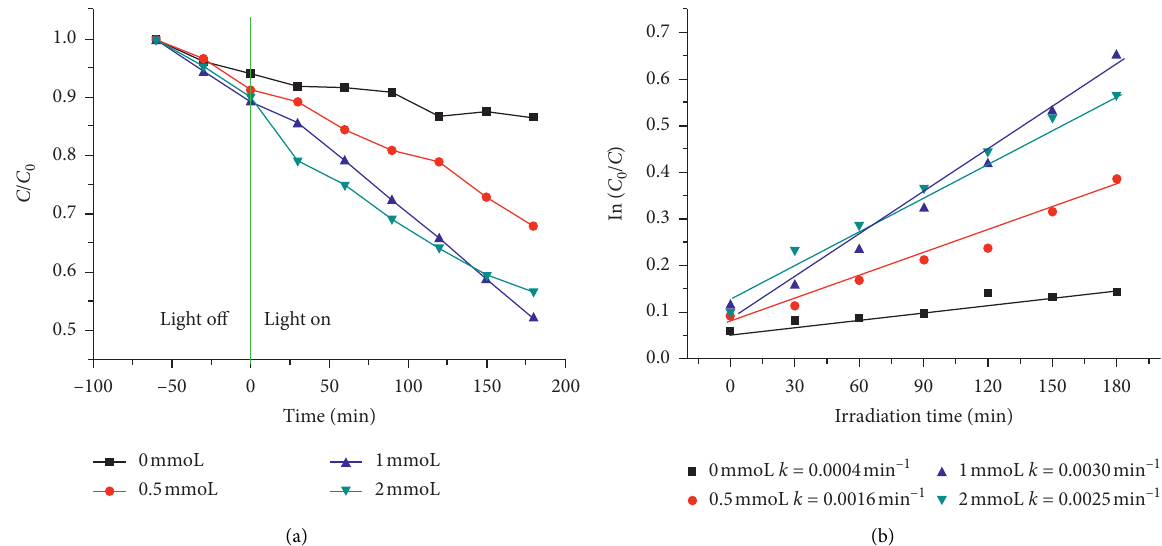
Figure 1: Effects of TBAOH dosages on the carbamazepine degradation